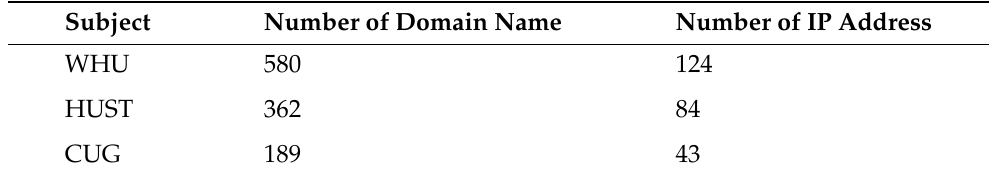
Table 8. Numbers of domain names and IP addresses acquired for three universities by WebHunt.